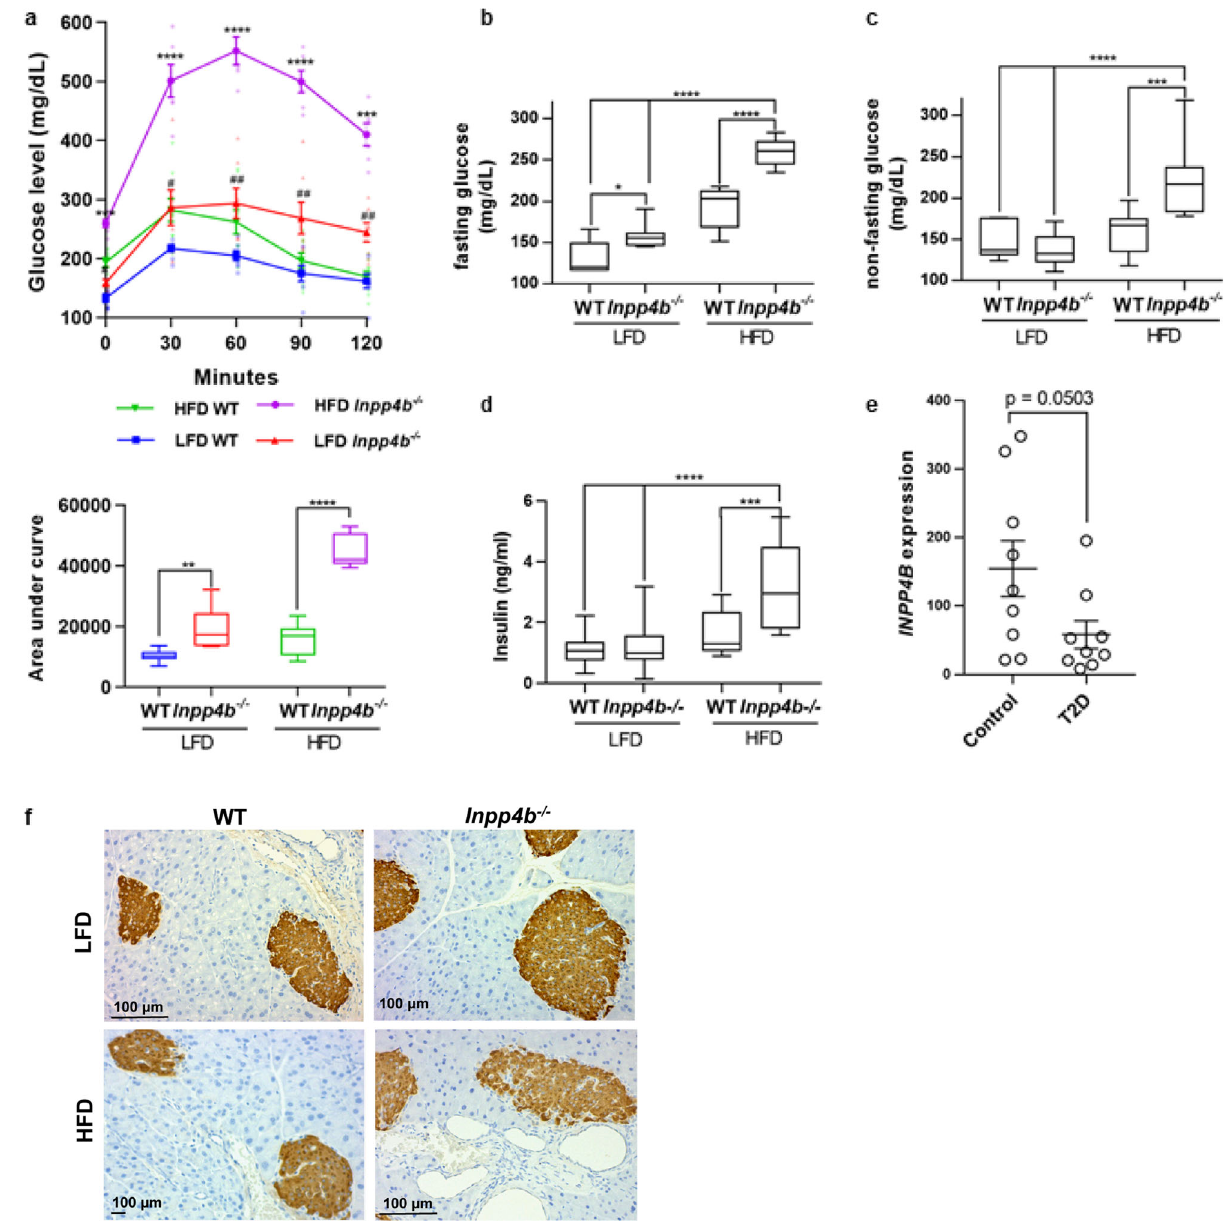
Fig. 3 INPP4B protects mice from hyperglycemia and diabetes. a Oral glucose tolerance test of LFD WT ( N = 7), LFD Inpp4b − / − ( N = 7), HFD WT ( N = 9), and HFD Inpp4b − / − ( N = 6) mice following a 2 g/kg oral glucose challenge. # is used to indicate statistically signi fi cant difference between LFD groups and * is used to indicate statistically signi fi cant difference for HFD groups. LFD WT, LFD Inpp4b − / − , HFD WT, and HFD Inpp4b − / − groups are represented by blue line with squares, red line with up-pointing triangles, green line with down-pointing triangles, and purple line with circles, respectively. b , c Blood glucose was measured in the same group as ( a ) after 6 h of fasting ( b ) or non-fasting ( c ) LFD WT, LFD Inpp4b − / − , HFD WT and HFD Inpp4b − / − mice. d Blood insulin was measured by ELISA in the same groups as ( a ). e INPP4B expression in livers of subjects with or without type II diabetes (T2D) were exported from GSE15653. f Representative pancreata sections from LFD WT, LFD Inpp4b − / − , HFD WT, and HFD Inpp4b − / − mice were stained for insulin and counterstained with hematoxylin ( * p < 0.05, *** p < 0.001, **** p < 0.0001. Exact p values are provided in Supplementary Data